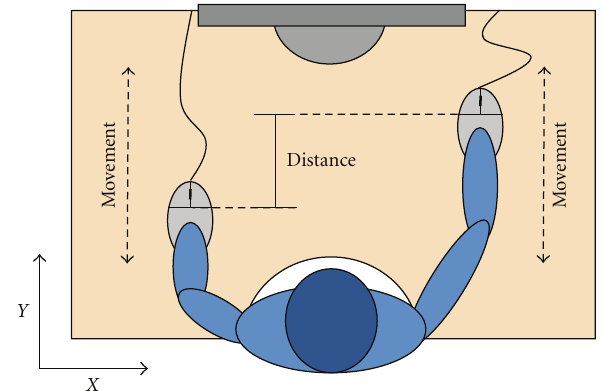
Figure 2: Sketch of the NTT-bilateral training task. Two mice track the position of right and left hands. The training consists of bilateral and coordinated displacement of the arms in the Y axis to change the heading direction of the NTT-virtual glider. The distance between hands in the Y axis defines the direction and the turning speed. See text for further